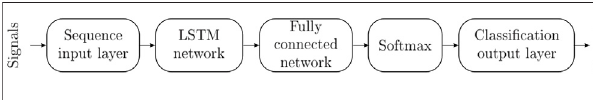
FIGURE 8 | Architecture used for the LSTM